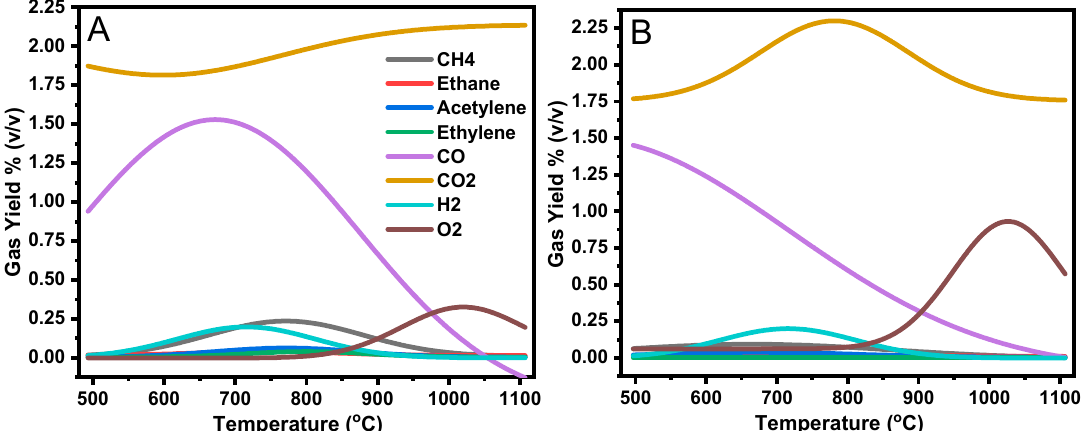
Figure 7. Gas yield composition as a function of gasification temperature at the theoretical equivalence ratio of 0.48 ± 0.05 for ( A ) flame retardant cotton and ( B ) 0.46 ± 0.02 after flame retardant substrate removal.